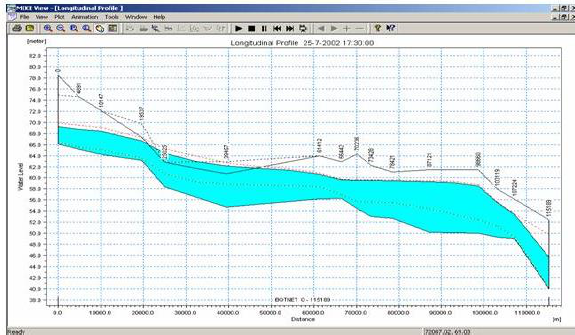
Fig. 4.0. Longitudinal Water profile with maximum water level at Runnisaidpur on 03.7.02 at 12.00